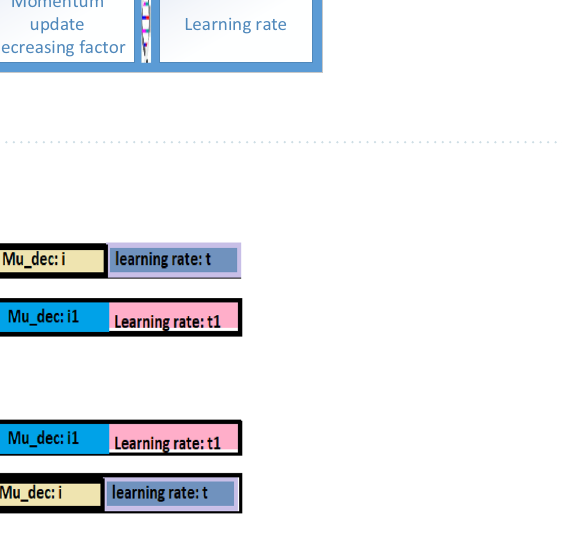
Figure 9. Single-point crossover implemented in the GA-ANN Classifier.